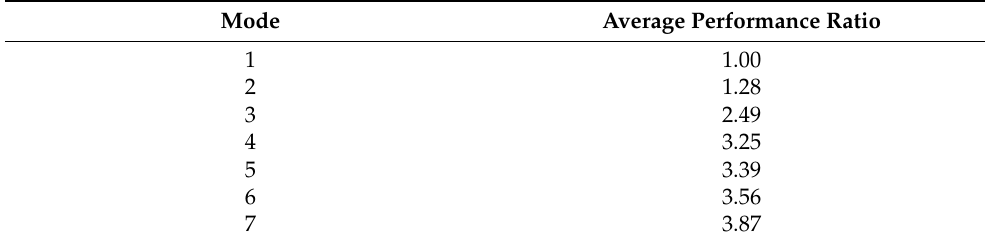
Table 10. Performance